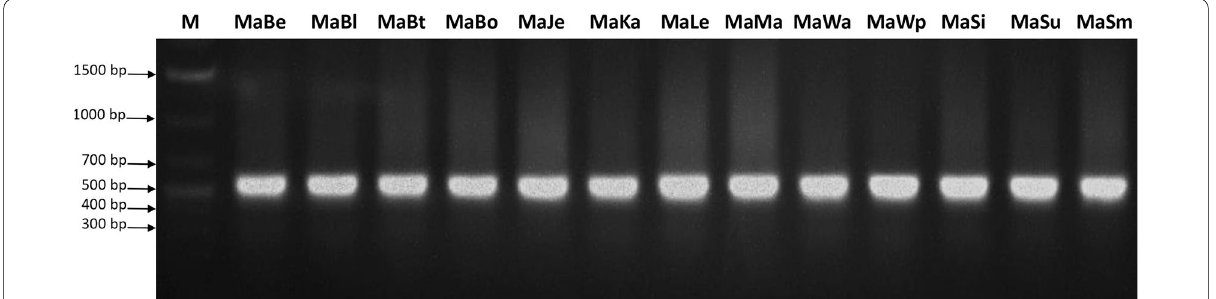
Fig. 3 PCR products amplified with ITS primers from 13 isolates of